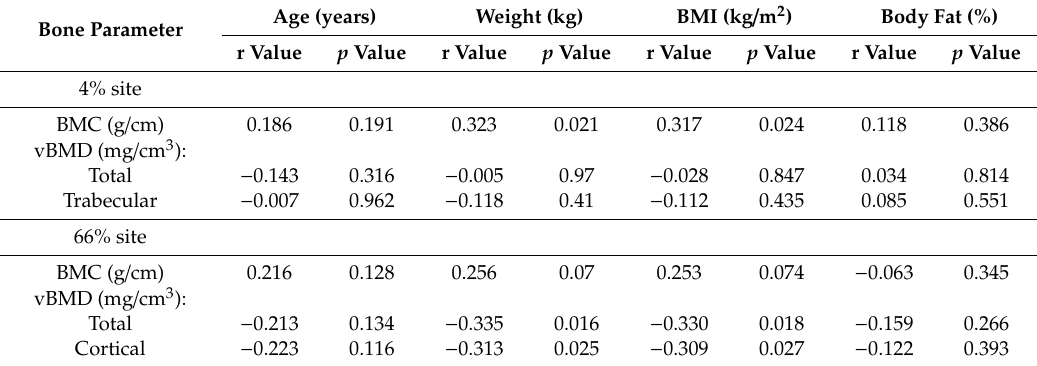
Table 4. Correlations between age and adiposity and radial bone densitometry assessed by pQCT of Brazilian women living in England by age tertiles ( n = 51) 1